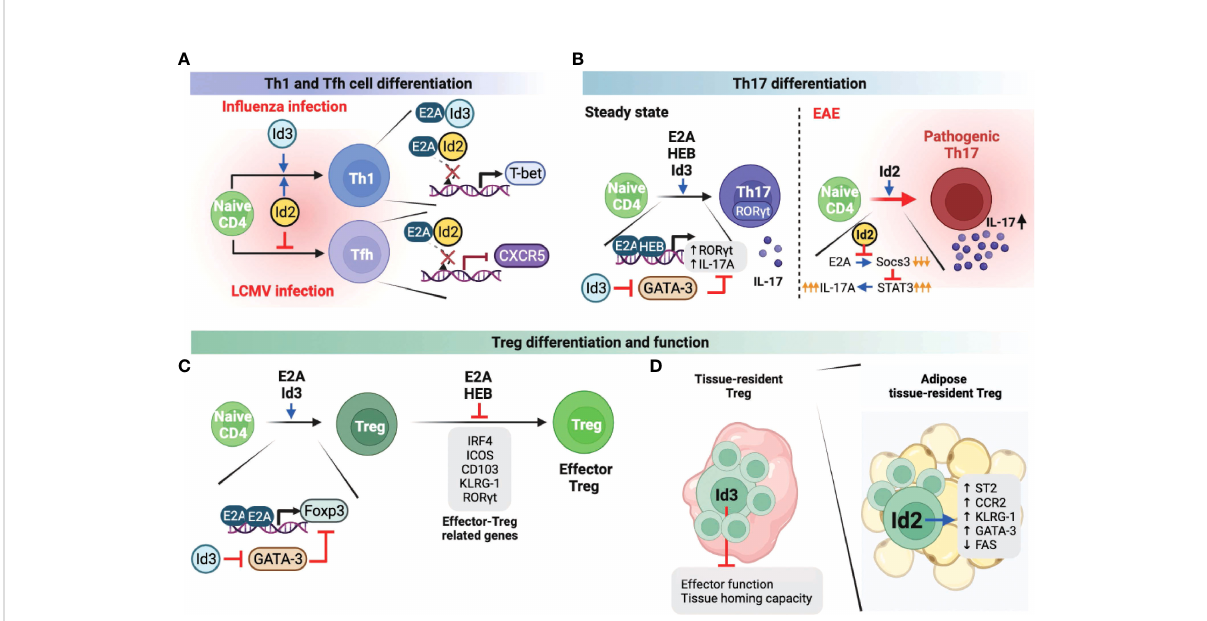
FIGURE 2 Role of E and ID proteins during peripheral CD4 T cell differentiation and function. A-C. E and ID proteins in fl uence Th1 and Tfh cell differentiation (A) , Th17 cell differentiation and function (B) , and Treg and effector Treg differentiation and function (C) under steady-state as well as infectious and autoimmune conditions. (D) Id3 negatively in fl uences the tissue-resident Treg effector function and tissue homing capacity. In adipose tissue, tissue-resident Treg cells enhanced Id2 expression, which can positively regulate the Treg effector function and survival. This fi gure was created with